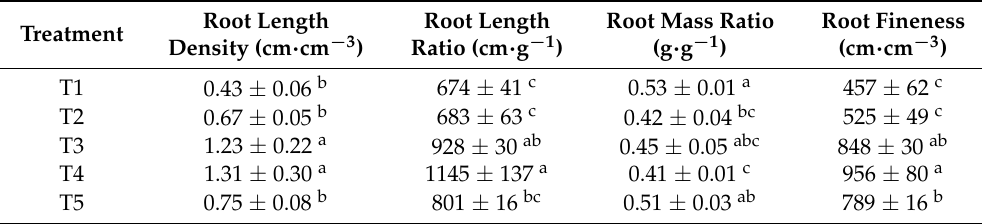
Figure 3. Influences of co-application of TW and chemical fertilizers (root length ( A ), root volume ( C ), surface area ( B ), and root diameter ( D ). Without amendment (T1), chemical fertilizers (T2), TW 2.5% + F (T3), TW 5% + F (T4) and TW 10% + F (T5). The data showed the mean of three replications, and error bars are standard deviations. Different letters indicate there were significant differences ( p < 0.05) in the LSD means comparisons between the treatments mean. Table 2. Influence of chemical fertilizers and combined with milk tea waste (TW) on root traits after eight weeks (mean ± standard error; n = 3)